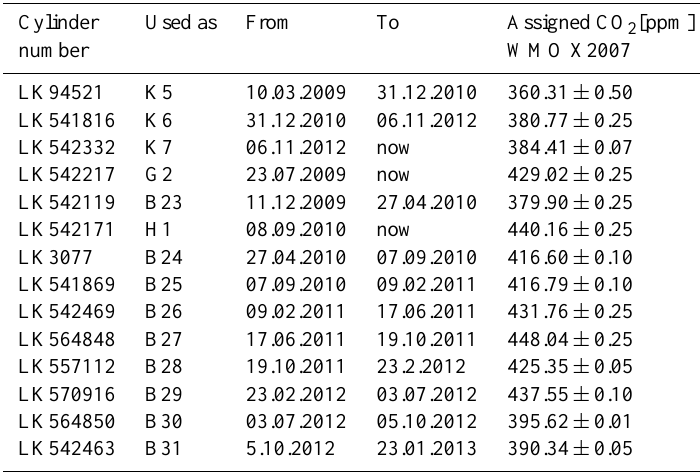
Table 3. List of calibration gas cylinders used for the CRDS system in the period from 2010 to 2012 as measured at the Empa laboratory. Cylinder Used as From To Assigned CO 2 [ppm] WMO